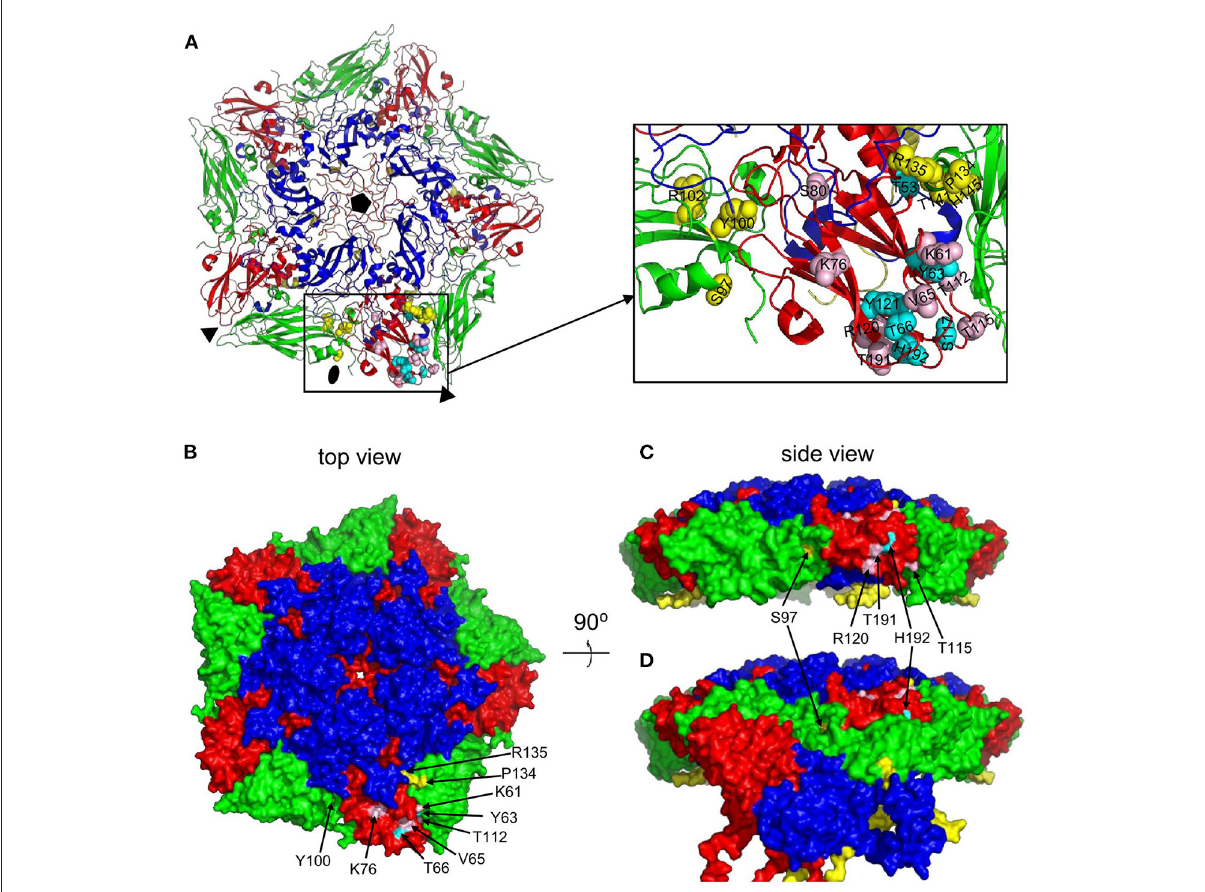
FIGURE4 Surface accessibility of M702F cross-linked residues mapped on a 12S pentamer of the A22IRQ structure (PDB: 4GH4). The M702F cross-linked residues forming a single antigenic site on VP3 of the protomer at the bottom and the relevant VP2 residues adjacent to this VP3 molecule are shown as cartoon graph (A) . Cross-linked residues are shown with side chains as yellow (VP2) or cyan/pink (VP3) spheres. The surface accessible area of a pentamer is shown from a top view (B) or side view (C, D) . The nine residues that are surface accessible even when 12S pentamers associate are indicated by arrows (B) . Cross-linked residues surface exposed at the 2-fold symmetry axis are shown by a side view of a single pentamer (C) or this same pentamer with a protomer of an adjacent 12S pentamer that associates at the 2-fold symmetry axis in a 146S particle (D) . Among the 5 cross-linked residues at this 2-fold symmetry axis (arrows), R120, T191 and T115 are only surface accessible in a 12S pentamer (C) but not a 146S particles (D) . VP1, blue; VP2, green; VP3, red; VP4, yellow. Fivefold symmetry axis, pentagon; 3-fold symmetry axis, triangle; 2-fold symmetry axis, oval.